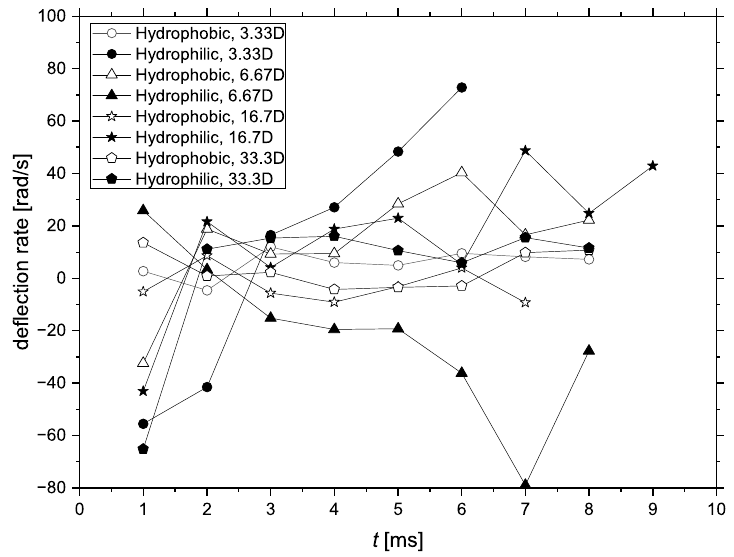
Figure 14. Relationship between the deflection angular rate of the projectile and time under different working